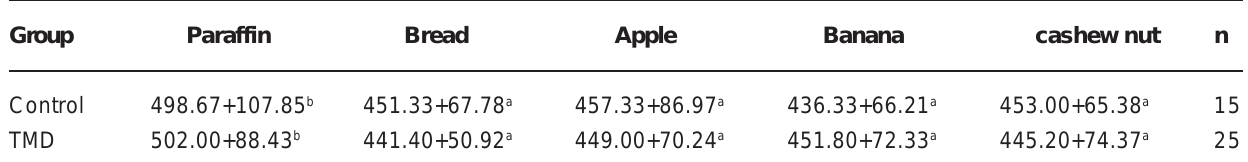
Groups with the same letters are not statistically different. TABLE 2- Mean values (in ms) and standard deviation of the duration of the masticatory cycle during mastication of different materials, for the control and TMD